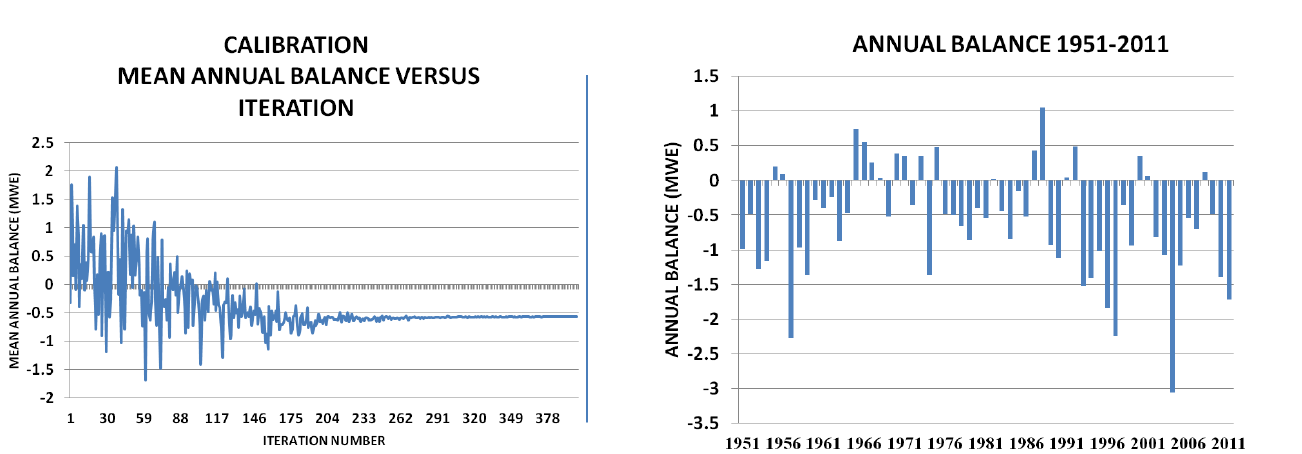
Fig. 5. Annual balance of the Bering Glacier for the 1951–2011 Figure 5 . Annual balance of the Bering Glacier for the 1951-2011 250 period. The average annual balance is − 0.6mw.e. The minimum period. The average annual balance is –0.6 mwe. The minimum balance 251 11 for the period (-3.1 mwe) occurred in 2004 . 252 balance for the period ( − 3.1mw.e.) occurred in 2004. 253 An advantage of the PTAA model is that it produces daily balances for each 254 area-altitude interval and for the total glacier, therefore balance results can 255 be clearly displayed in a format similar to hypothetical daily balances 256 suggested in earlier publications (Meier, 1962, Anonymous, 1969 and Mayo 257 et al, 1972). The terms Accumulation and Ablation balance were introduced 258 in Tangborn and Rana (2000) to reduce the confusion caused by cumulative 259 snowfall in the Himalayas during the monsoon season of June-September 260 being designated Winter Balance. Also, ablation at lower elevations in the 261 Himalayas often occurs during the winter months, therefore Summer 262 Balance is incorrect. 263